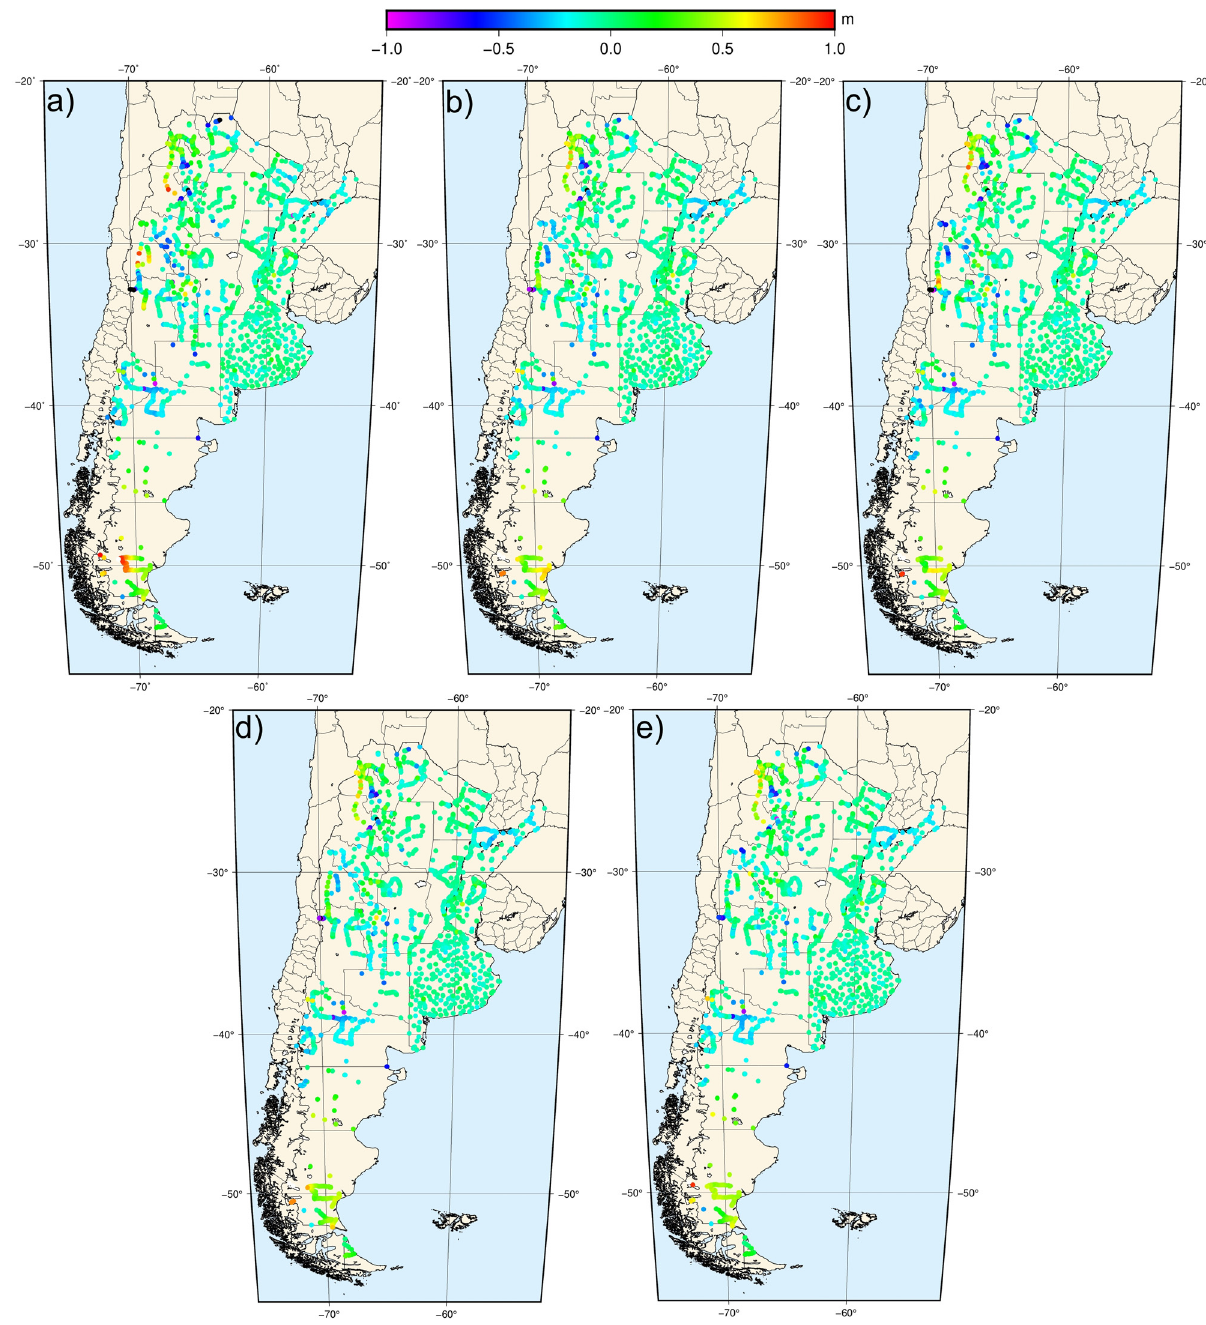
Figure 3: Di ff erences between each GGM - HR and geoid heights derived from GPS/levelling benchmarks over Argentina: ( a ) EGM2008, ( b ) EIGEN - 6C4, ( c ) GECO, ( d ) SGG - UGM - 2, and ( e )